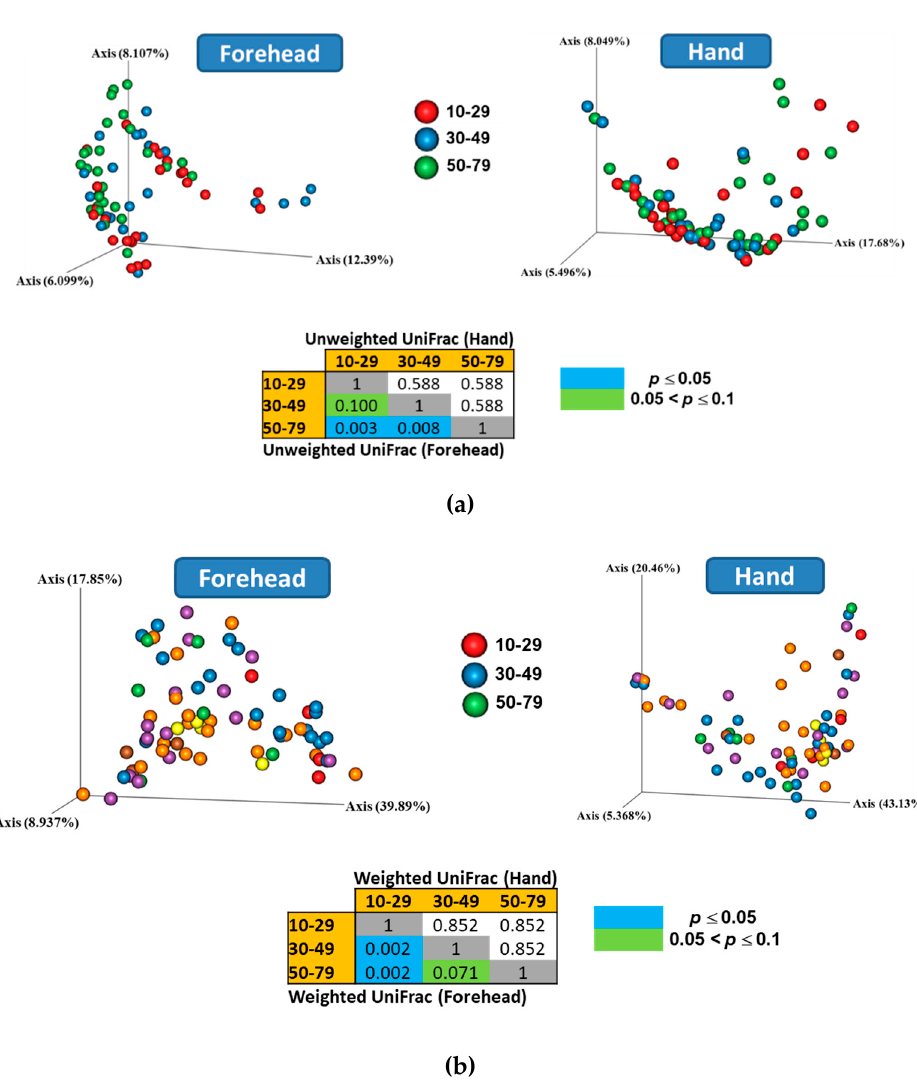
Figure 3. Skin microbiota distribution among the age groups based on the ( a ) unweighted and ( b ) weighted UniFrac distances. Non-parametric Permutational Multivariate Analysis of Variance (PERMANOVA) was used to compare the skin microbiota among age groups.